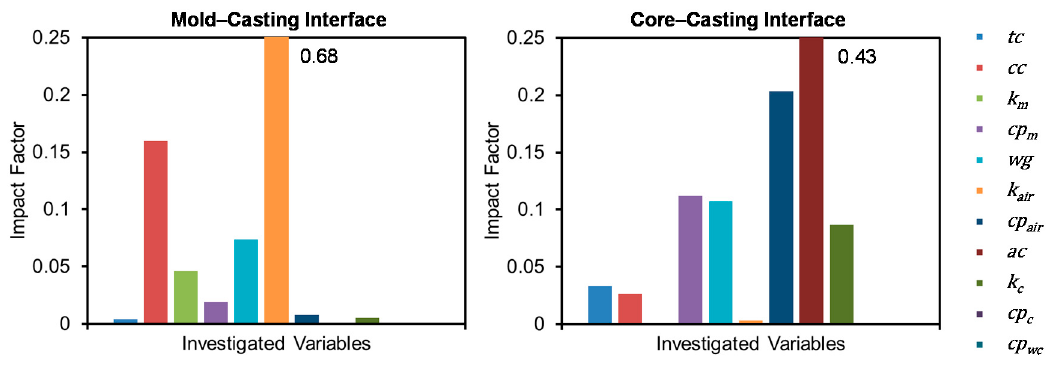
Figure 6. Investigated variables and their impact factors for a casting interface temperature of 460 °C on the left side for the casting–mold interface and, on the right side, for the casting–core interface.